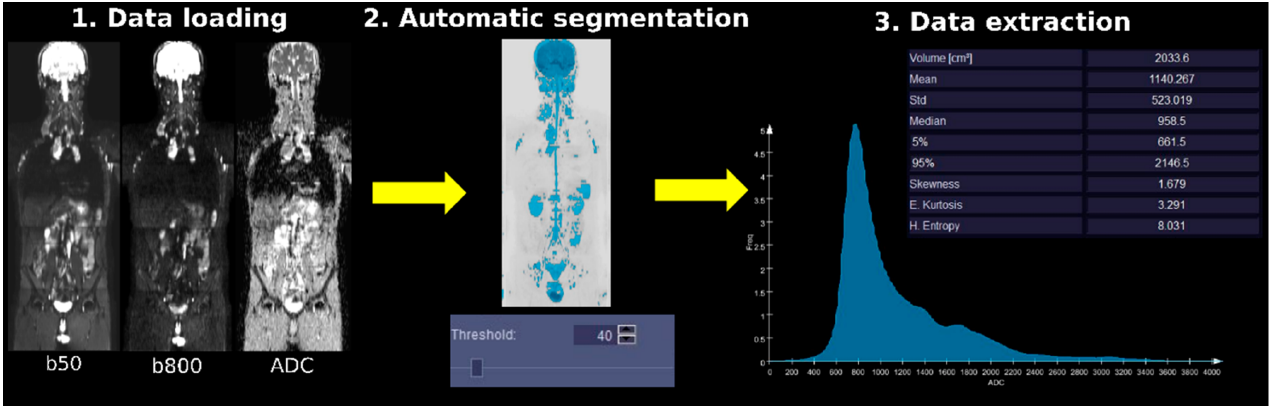
Figure 2. Whole-body diffusion weighted imaging (WB-DWI) image analysis and data extraction process using syngo, via Frontier MR Total Tumor Load software. Reprinted from [56].